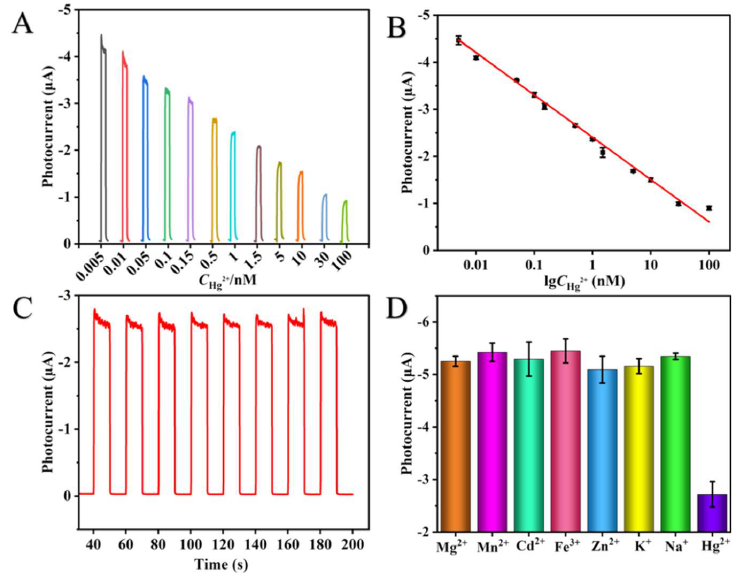
Figure 4. ( A ) PEC reaction of Hg 2+ at different concentrations; ( B ) Linear relationship between photocurrent and logarithm value of Hg 2+ concentration; ( C ) Sensor stability within 200 s; ( D ) Selectivity of PEC system.